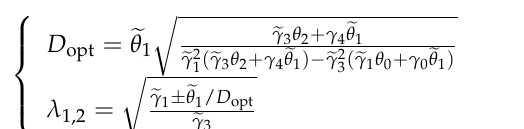
According to FPA, the optimal tuning damping ratio ζ d ∞ can be determined by assigning the fixed points to the peaks of the DAF, i.e., Figure 2b. Based on the quotient rule of derivation, the following equation may be obtained: